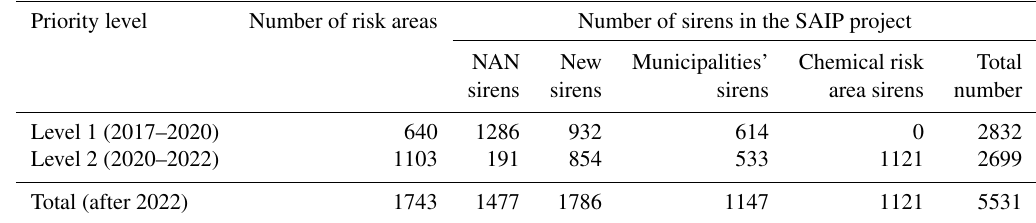
Table 1. Number of sirens in the NAN network and in the SAIP project expected in 2022 (data from Vogel, 2017). Priority